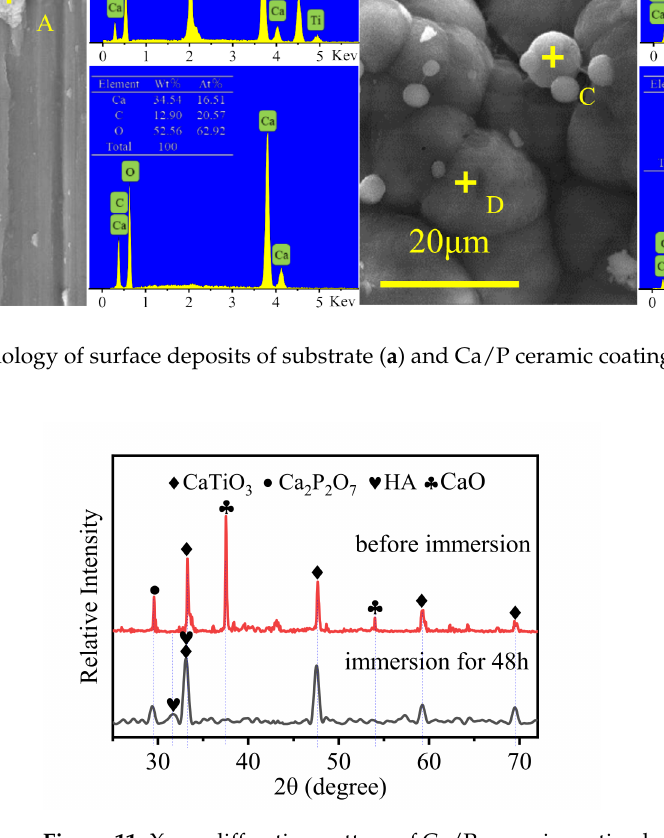
Figure 11. X-ray diffraction pattern of Ca/P ceramic coating before and after SBF